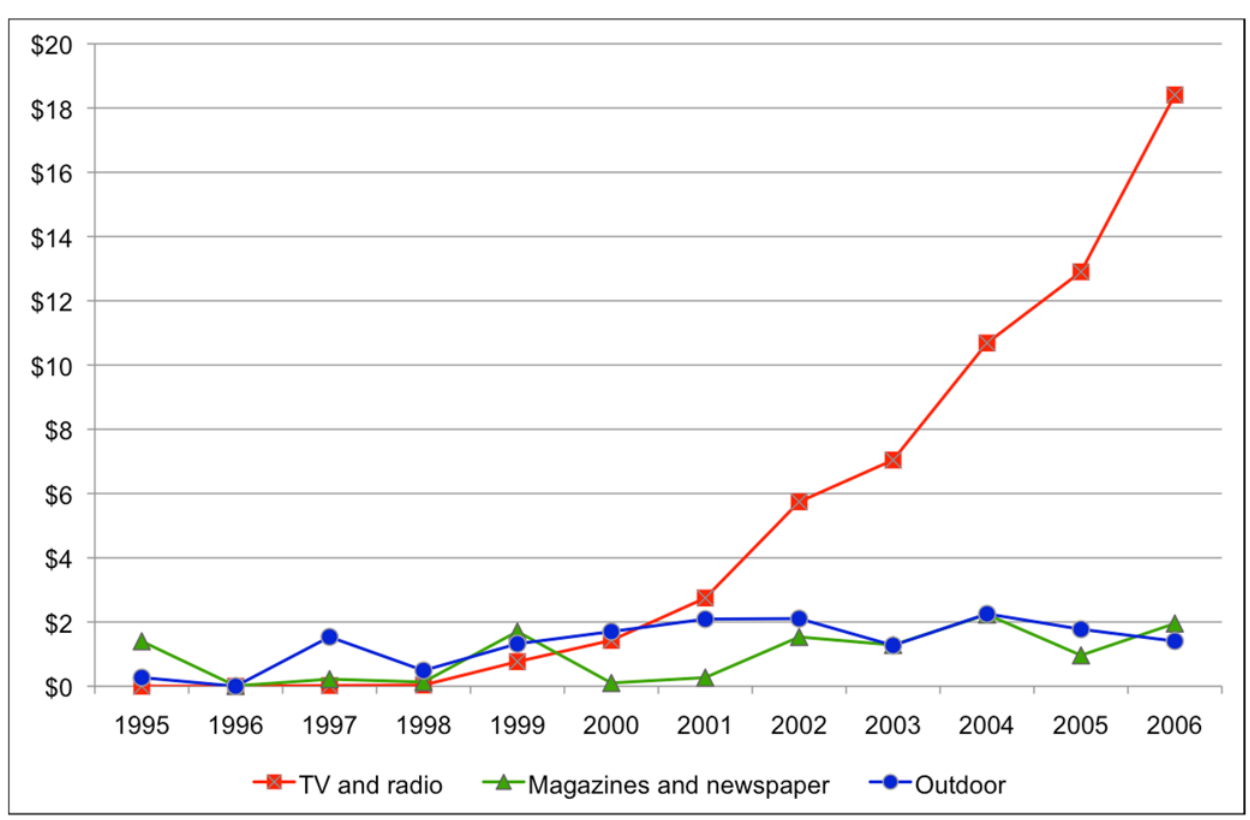
Figure 1. Inflation-adjusted spending on branded direct-to-consumer advertising, 1995 to 2006 (year-2006, CAD$ millions).